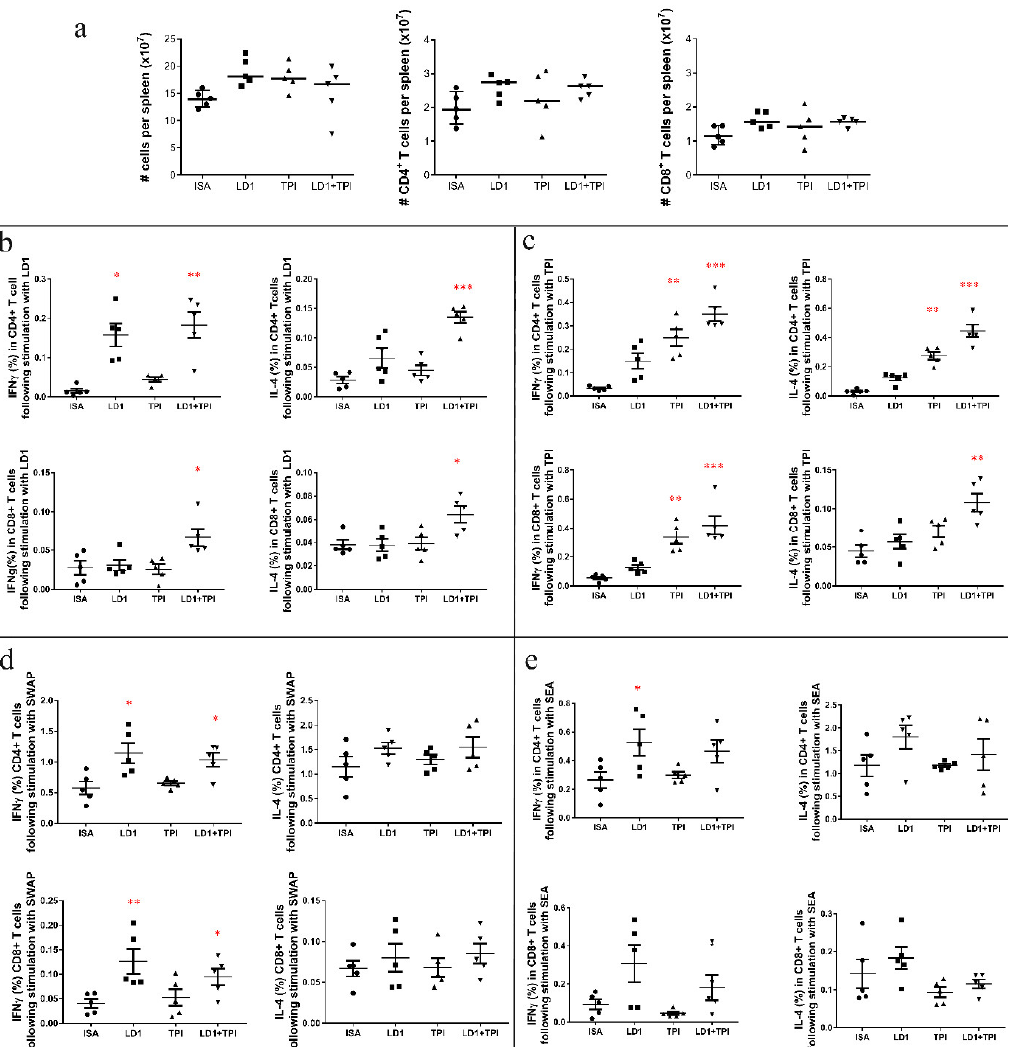
Figure 2. The cytokine profiles of splenocytes recovered from mice vaccinated with rSjLD1, rSjTPI and rSjLD1 + SjTPI adjuvanted with ISA720 at 6 weeks post-challenge. Splenocytes isolated from vaccinated and adjuvant control mice were stimulated with medium (as a control), rSjLD1, rSjTPI, SEA and SWAP for 72 h, followed by intracellular cytokine staining. After exclusion of doublets and dead cells identified with the live/dead marker, the CD3 + population (total T cells) were further classified into CD4 + and CD8 + subsets. Total splenocytes, CD4 + T cells and CD8 + T cells isolated from each spleen were determined ( a ) and the proportion of IFNγ and IL-4 producing splenic CD4 + or CD8 + T cells were determined after stimulation with ( b ) rSjLD1; ( c ) rSjTPI; ( d ) SWAP; and ( e ) SEA (* p value ≤ 0.05; ** p value ≤ 0.001; *** p value ≤ 0.0001). Cytokine Responses in Mice Vaccinated with rSjLD1, rSjTPI and rSjLD1 + rSjTPI Adjuvanted with QuilA Following stimulation with rSjLD1 ex vivo, splenic CD4 + T cells isolated from mice immunized with rSjLD1 generated a significantly increased level of IFNγ ( p = 0.047) compared with QuilA adjuvant control mice (Figure 3a). When stimulated with rSjTPI, significantly increased production of IFNγ ( p = 0.048) and IL-4 ( p = 0.037) was observed in splenic CD4 + T cells isolated from mice immunized with this protein compared with cells from the control mice (Figure 3b). However, when